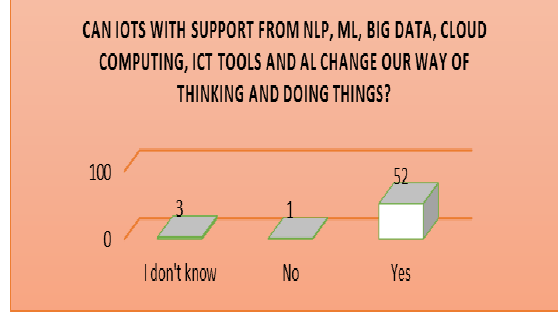
Figure 9 . question two ‘Can IoTs with support from NLP, ML, Big data, Cloud computing, ICT tools and Al change our way of thinking and doing things?’